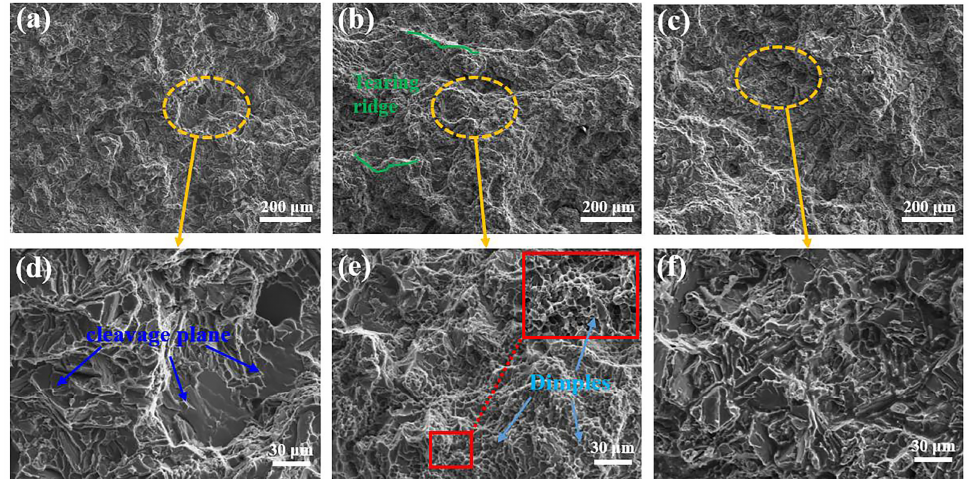
Figure 7. Fracture of as-cast Al-9.5Si-1.5Cu-0.8Mn-0.6Mg alloy: ( a , d ) A0 alloy; ( b , e ) A1 alloy; ( c , f ) B1 alloy.